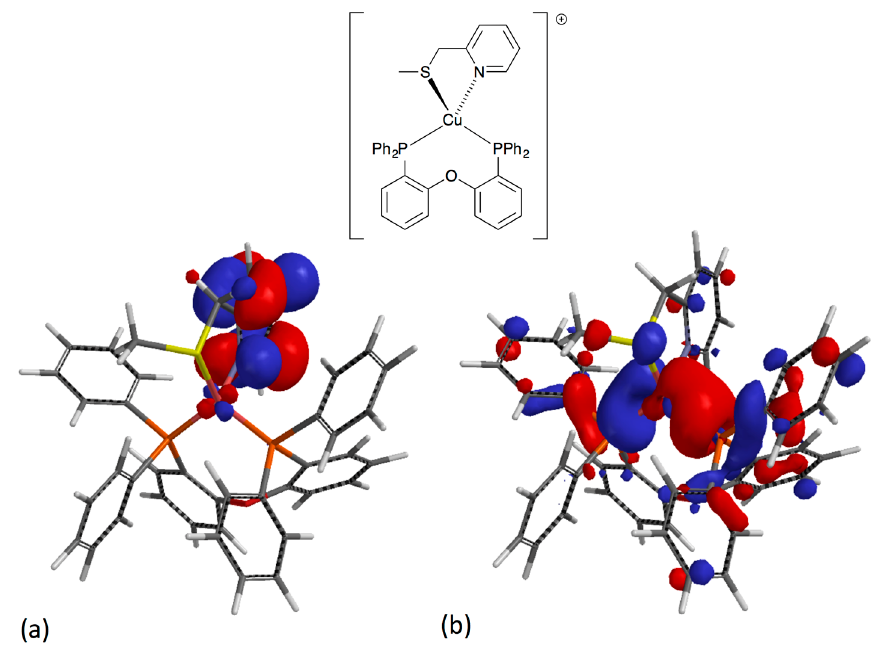
Figure 1. Characters of the ( a ) LUMO and ( b ) HOMO of the model [Cu(POP)(N^S)] + compound shown, and calculated at a DFT level (6-31G* basis set in vacuum).